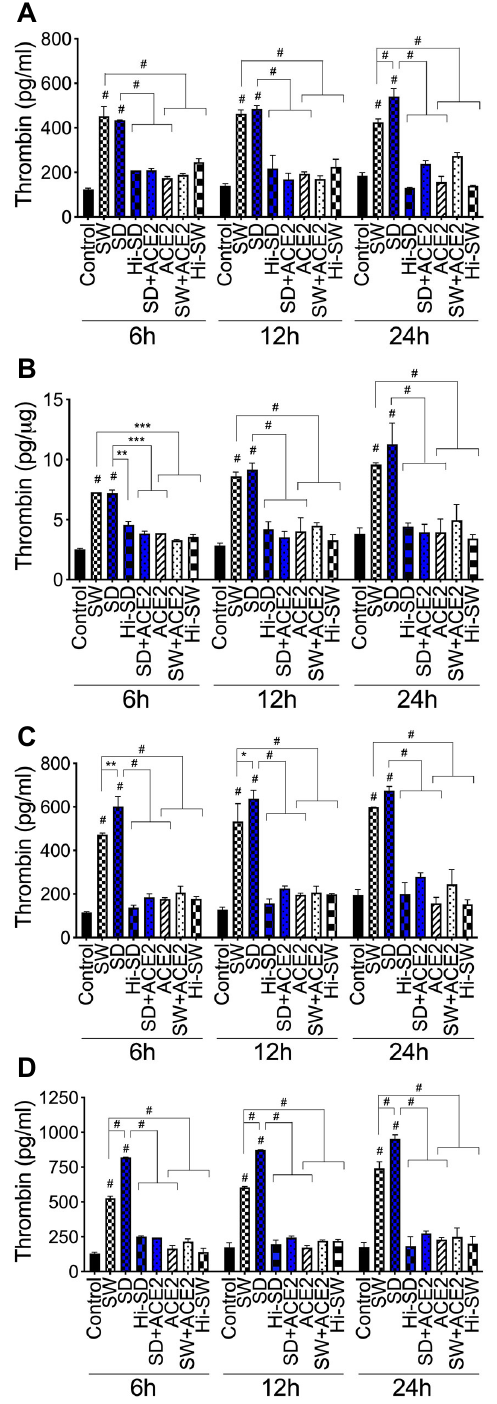
Figure 4. S-proteins and endothelial–neutrophil interactions induce thrombin expression and release in HLMEC. ( A , B ) HLMEC treated with S-proteins (1 nM SW or SD) for 6–24 h; ( C ) HLMEC treated 6 h with S-proteins, washed, and co-cultured with neutrophils for 6–24 h; ( D ) neutrophils treated 6 h with S-proteins, washed, and co-cultured with HLMEC for 6–24 h. Following treatments, thrombin levels in culture supernatants ( A , C , D ) and endothelial cell lysates ( B ) were quantified by ELISA. Data presented as mean ± standard deviation. Control: untreated cells; Hi-SW: cells treated with 1 nM heat-inactivated SW; Hi-SD: cells treated with 1nM heat-inactivated SD; ACE2: cells treated with rhACE2 (1 µ g/mL). * p < 0.05; ** p < 0.008; *** p < 0.0006; # p <